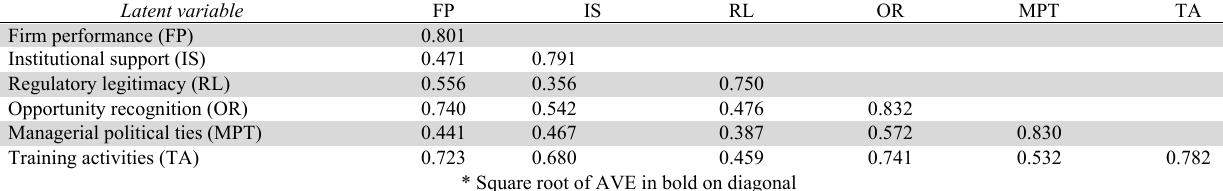
Discriminant validity (Formell and Lacker’s criterion) Latent variable